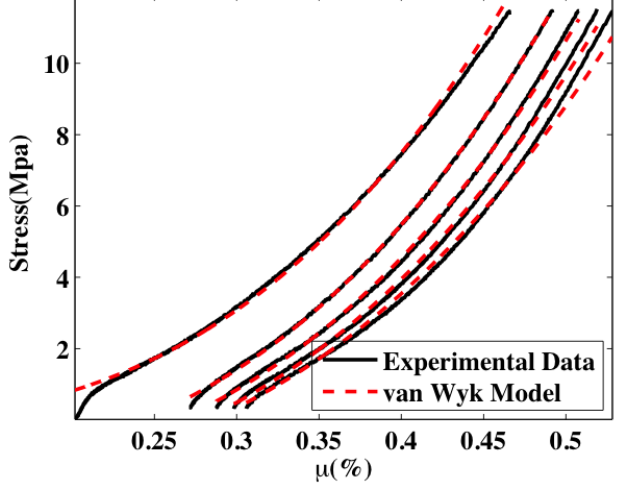
Figure 4. Loading portions of the curves in Figure 3 with fits to the van Wyk